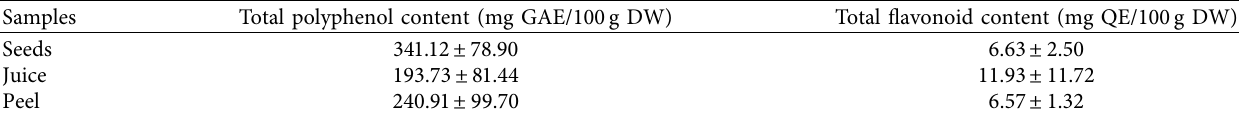
Table 3: Phytochemical analysis of ethanolic extracts of seeds, juice and peel of O. dillenii fruits.